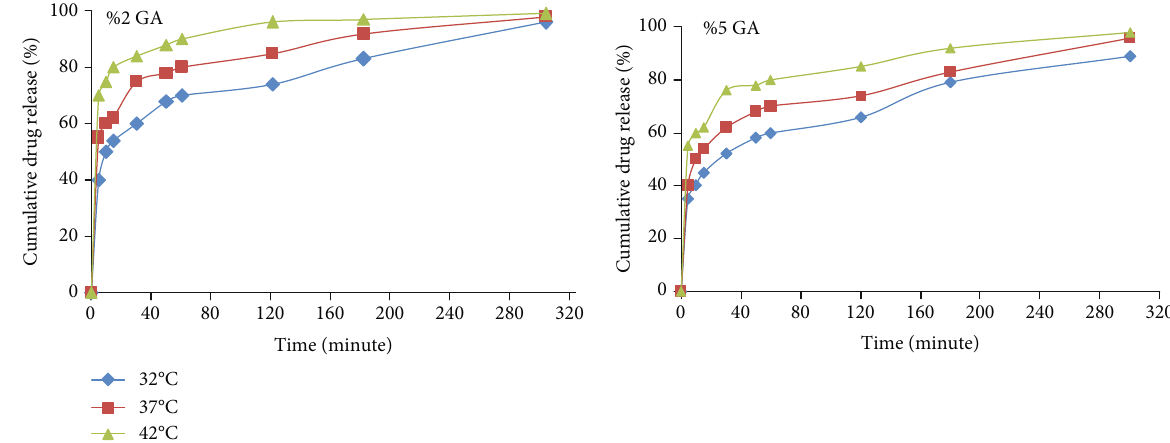
Figure 6: Drug release pro fi les of the HAp-GEL composites with changing temperature.